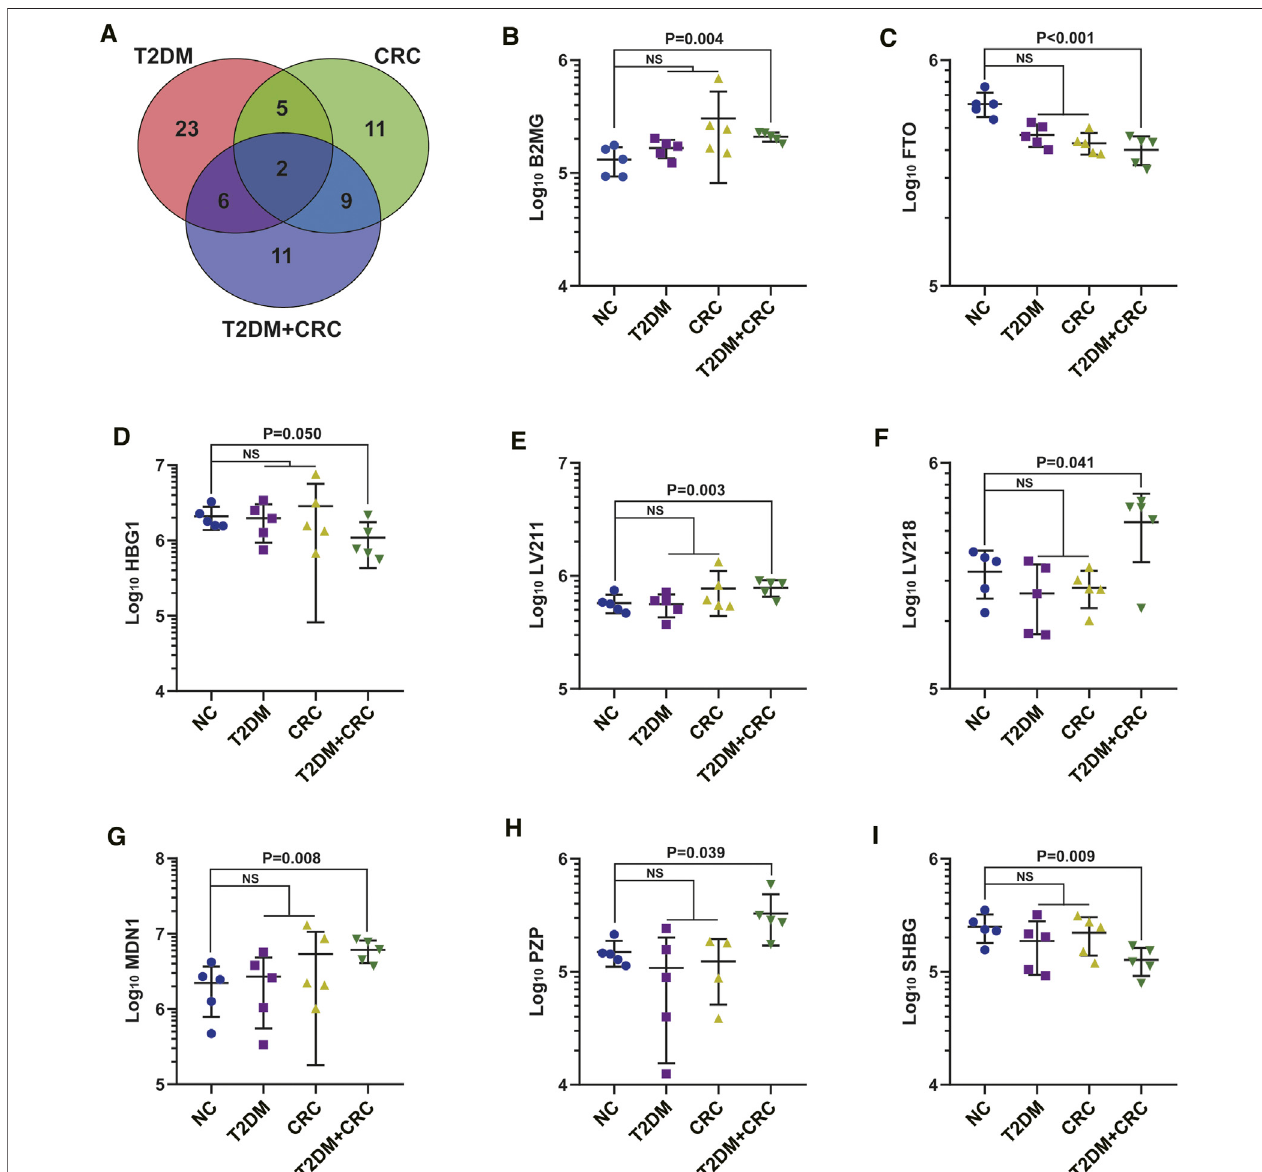
FIGURE 3 | Extraction of speci fi c serum proteins in T2DM + CRC patients. (A) Venn diagram of the 67 DAPs in the serum specimens from the four comparisons (T2DM vs healthy participants, CRC vs healthy participants and T2DM + CRC vs healthy participants). (B – I) Statistical graphs of eight speci fi c proteins levels. Unpaired t -test was used to compare the potential